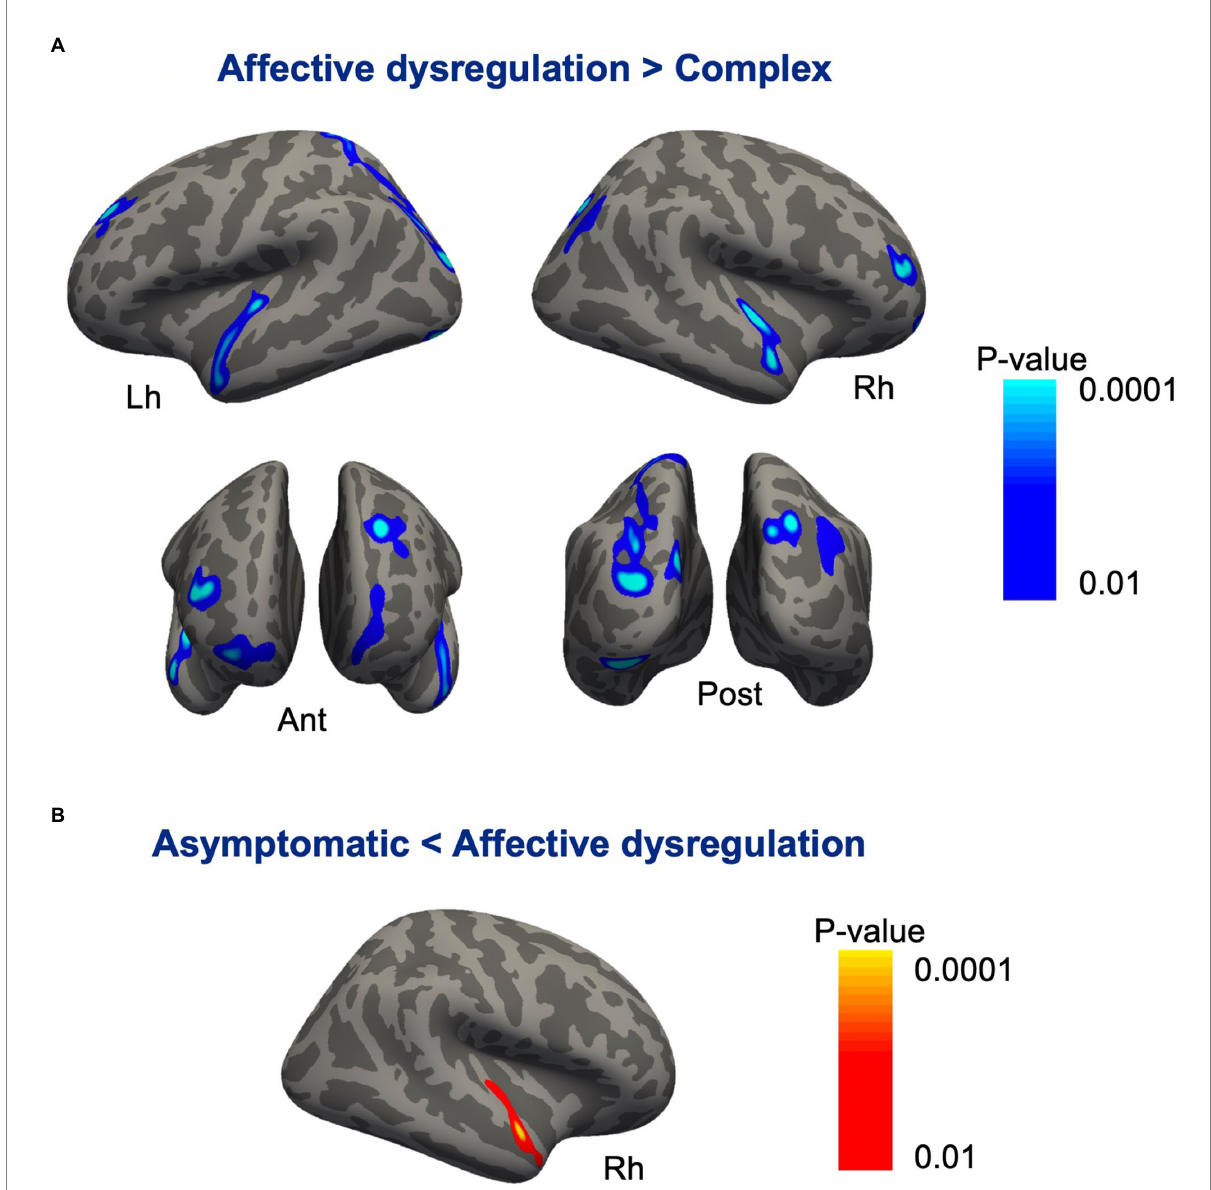
FIGURE 2 Cortical regions showing differences between the subgroups of pariticipants classified based on profiles of MBI domain symptoms. (A) Compared with the affective dysregulation group, the complex group revealed cortical thinning bilaterally in the inferior parietal cortex, lateral occipital cortex, lateral superior temporal gyrus, and frontopolar cortex. (B) The affective dysregulation group showed thicker cortex in the right superior temporal gyrus than the asymptomatic